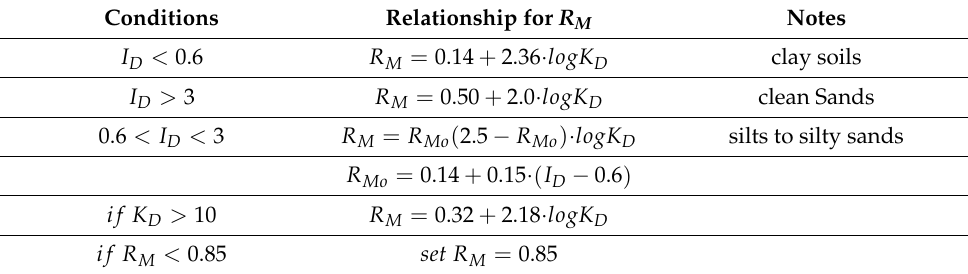
Table 5. Constrained modulus parameter ( R M ) for settlement calculations.